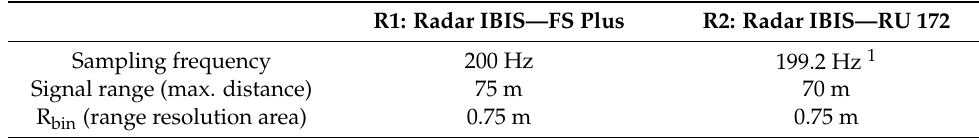
Table 3. Settings of used radars (bridge Valy).